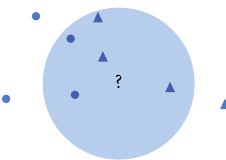
Figure 1: Example of K -nearest neighbor.